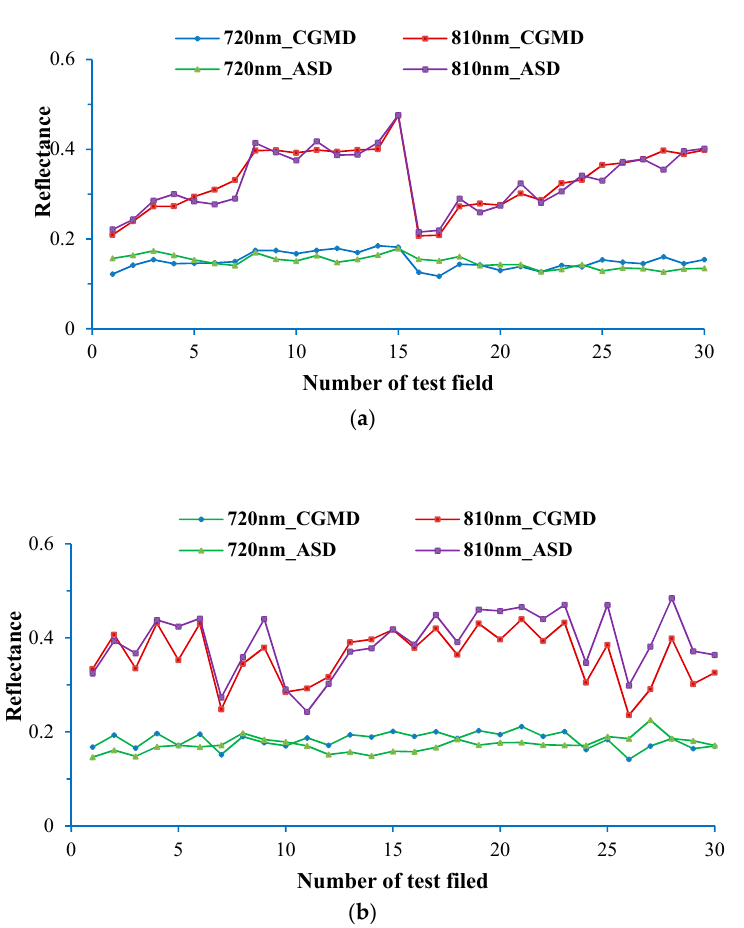
Figure 14. ( a ) Wheat; ( b ) Rice; Measurement of crop-canopy reflectance.